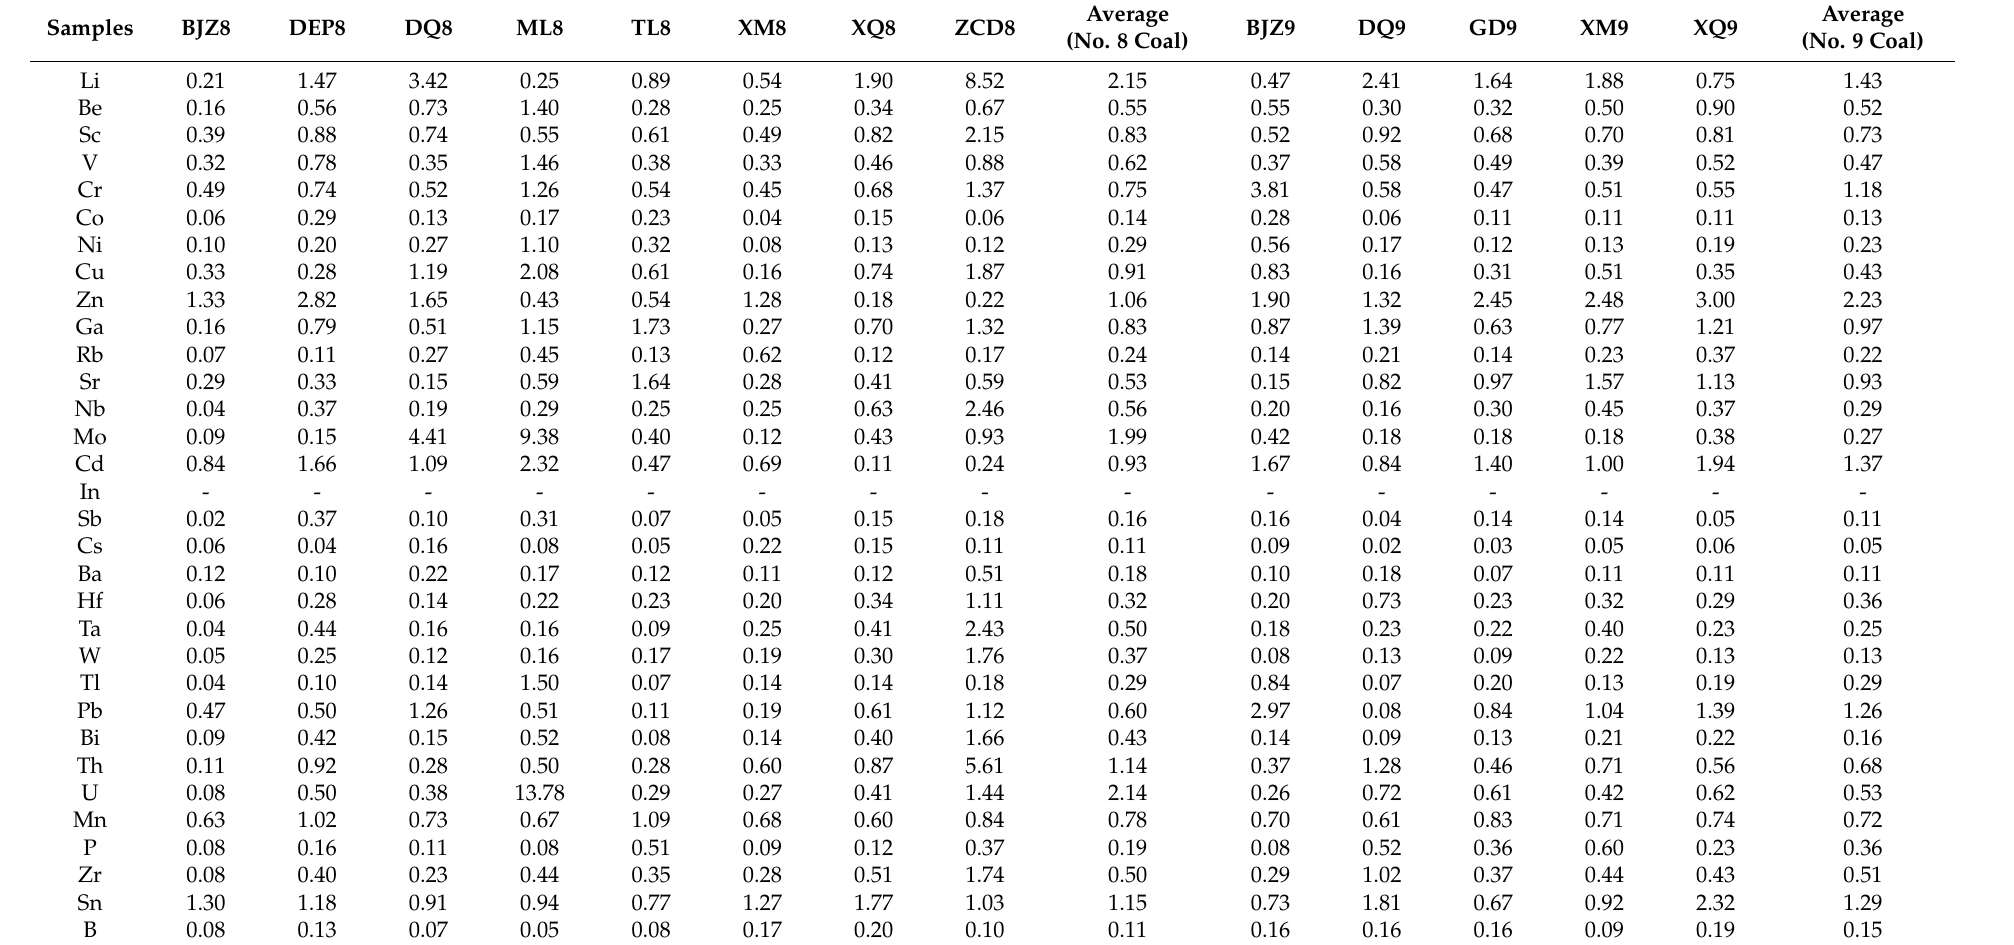
Table 6. Enrichment coefficient of trace elements in coal samples compared with that in